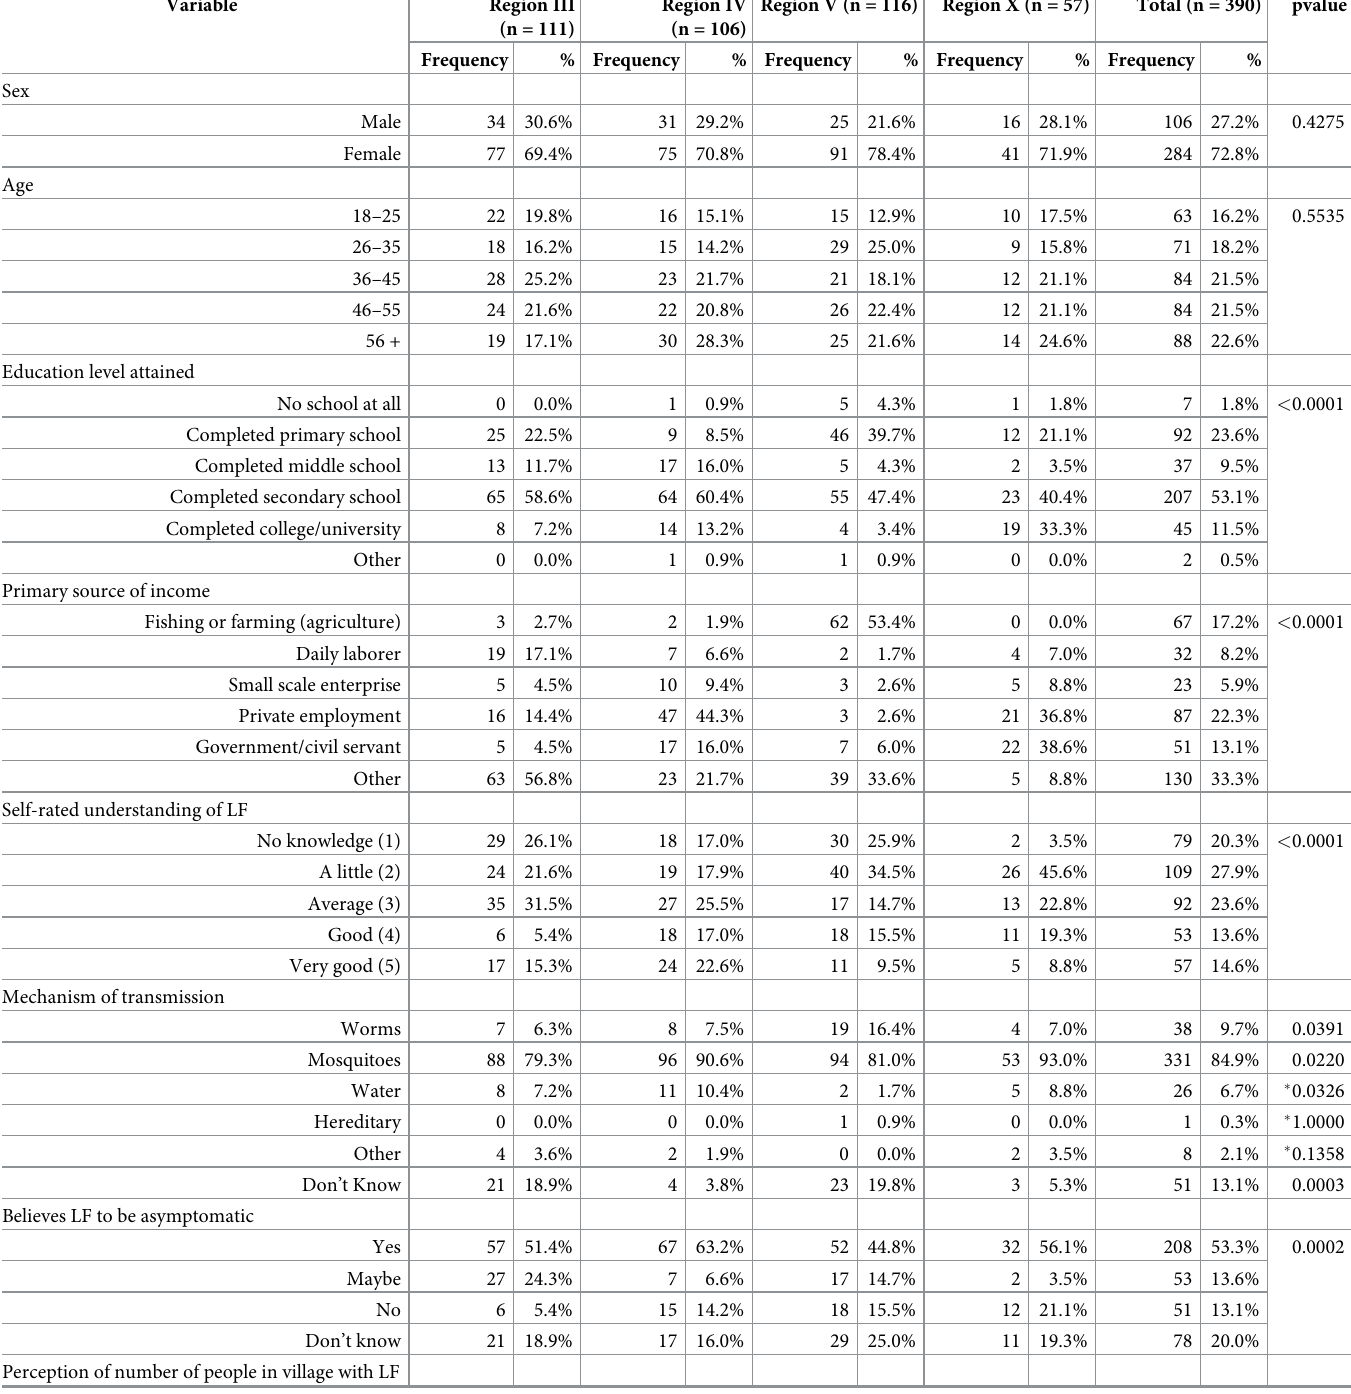
Table 1. Primary study population and key variables in total and subset by